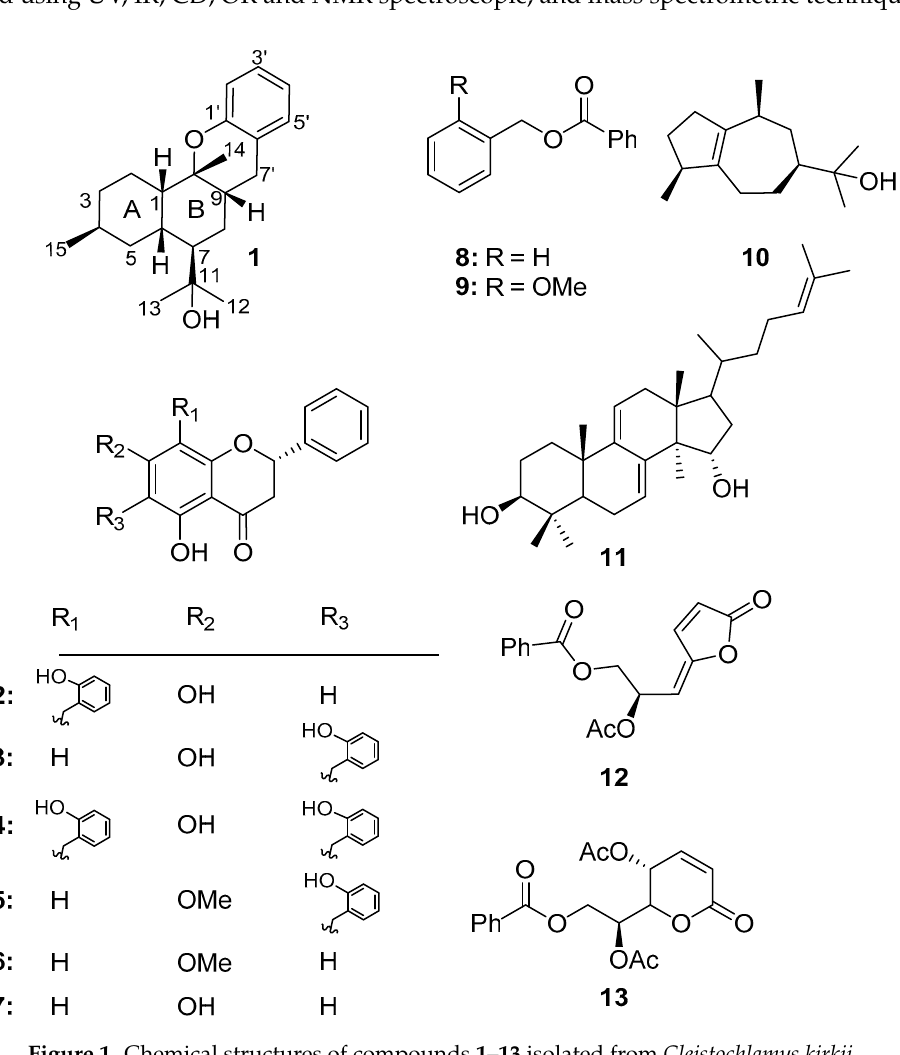
Figure 1. Chemical structures of compounds 1 – 13 isolated from Cleistochlamys kirkii .